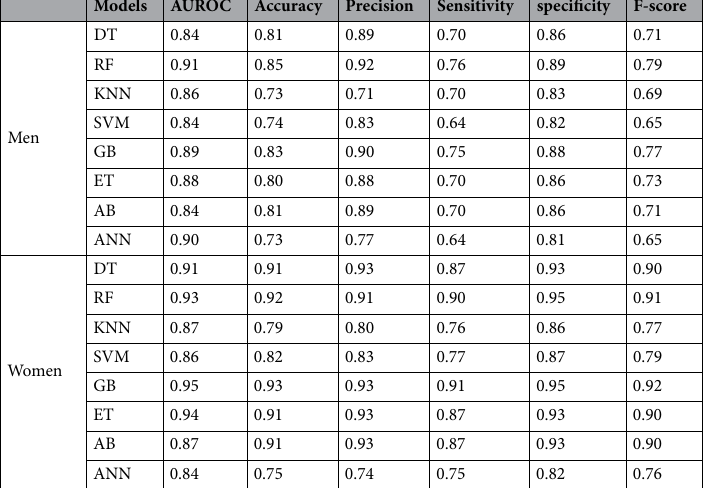
Table 4. Comparison of different classification algorithms in both men and women to predict healthy individuals, and individuals with osteopenia and OP.